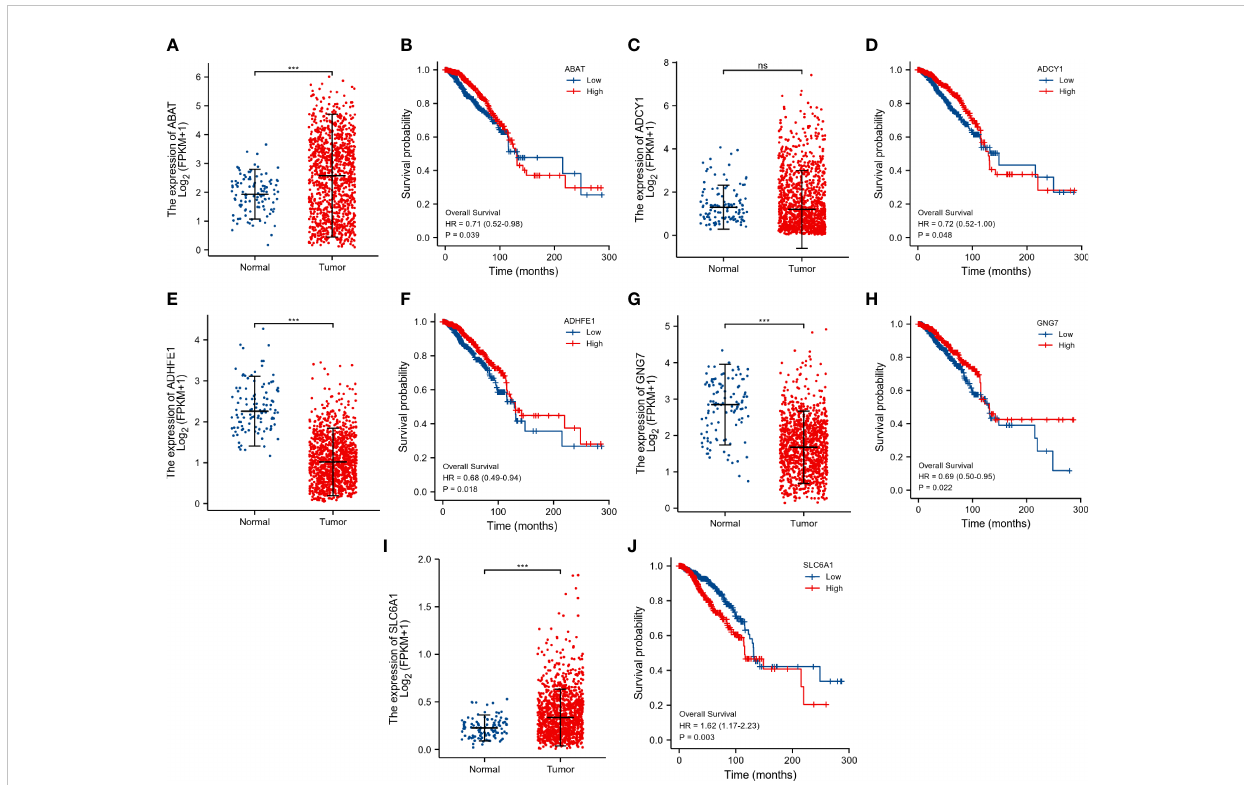
FIGURE 5 Evaluation of the prognostic value of DEGRGs in the TCGA dataset. The expression level of ABAT (A) , ADCY1 (C) , ADHFE1 (E) , GNG7 (G) , and SLC6A1 (I) in the TCGA dataset. Kaplan-Meier survival analysis of ABAT (B) , ADCY1 (D) , ADHFE1 (F) , GNG7 (H) , and SLC6A1 (J) in the TCGA breast cancer patients. ***p < 0.001. "ns" is no signi fi cant difference.